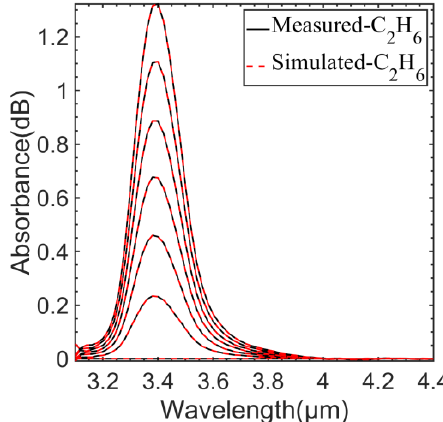
Figure 11. Comparison of measured and simulated absorption spectra of C 2 H 6 at different concen-